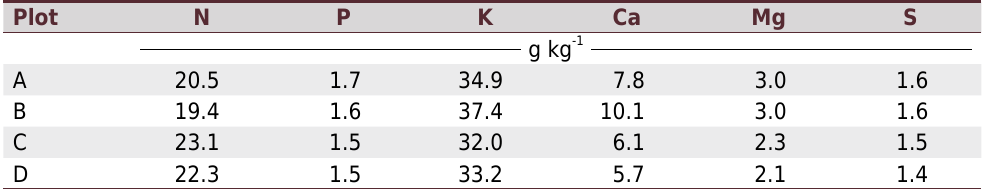
D 1.4 N = sulfuric acid digestion and determination by the Kjeldahl method; P (colorimetry), S (turbidimetry), K (flame emission photometry), Ca and Mg (atomic absorption spectrophotometry) determined in acid extract with digestion in nitric acid with perchloric acid, according to Silva